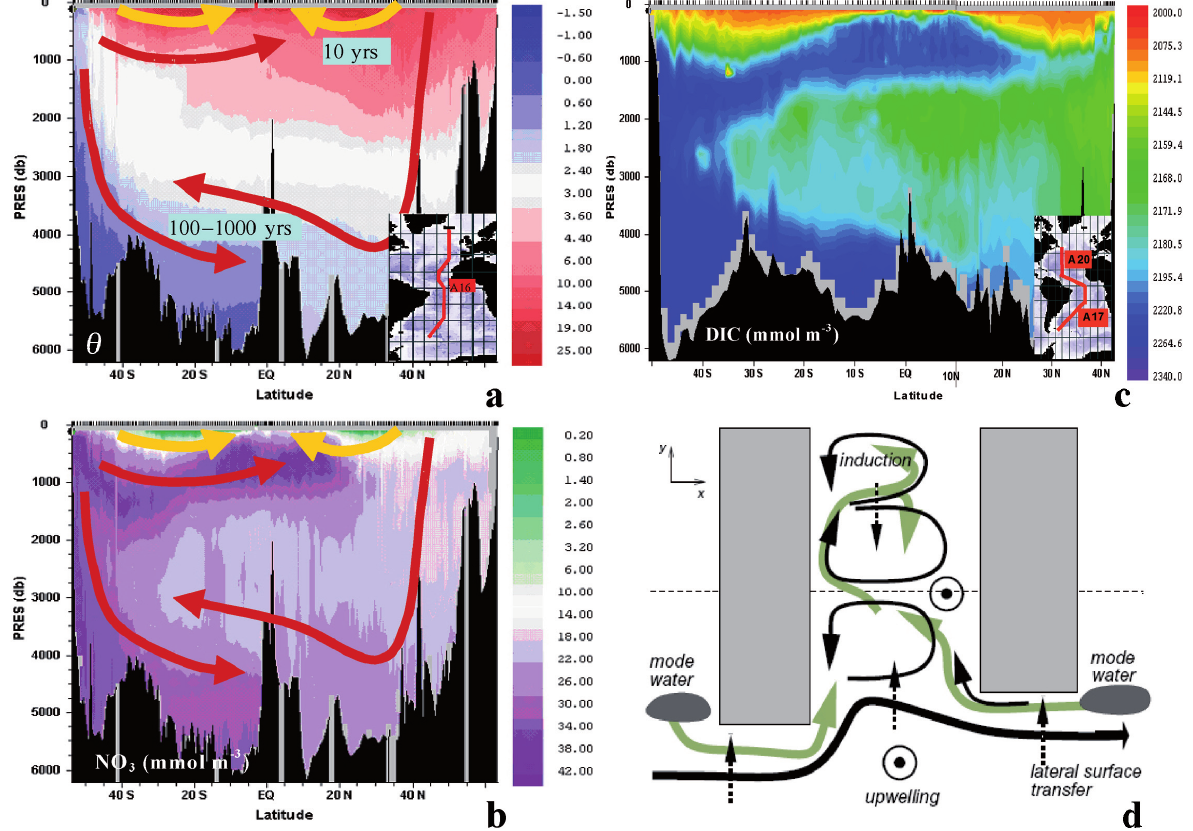
Fig . 2. – The data shown in (a) and (b) correspond to WoCe’s line a16, occupied in spring 1989 (southern and central portions) and summer 1989 (northern portion), while those shown in (c) correspond to WoCe’s lines a20 and a17, occupied in summer 1997 and winter 1994, respectively. (a) potential temperature and (b) nitrate concentration distributions, over which we have superimposed some gross circulation patterns and characteristic recirculation times. (c) Distribution of DIC; it is like nitrate but inorganic carbon is clearly non-limiting. (d) return paths in the upper ocean to the deep-convection regions. sub-antarctic mode waters (gray shaded) approach the surface waters in the equato- rial region and, in the north atlantic, join the upper gyre recirculation (black solid arrows) to reach the northern deep-water formation regions. The black dashed lines depict ekman transfer from high latitudes to the subtropical gyres. reproduced from Williams et al .